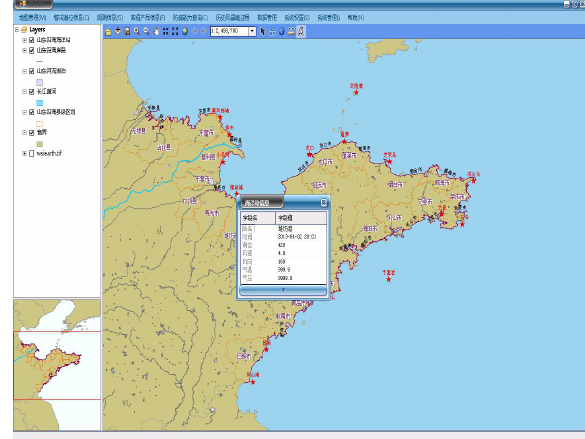
Figure 3. The presentation of the observation station’s information based on